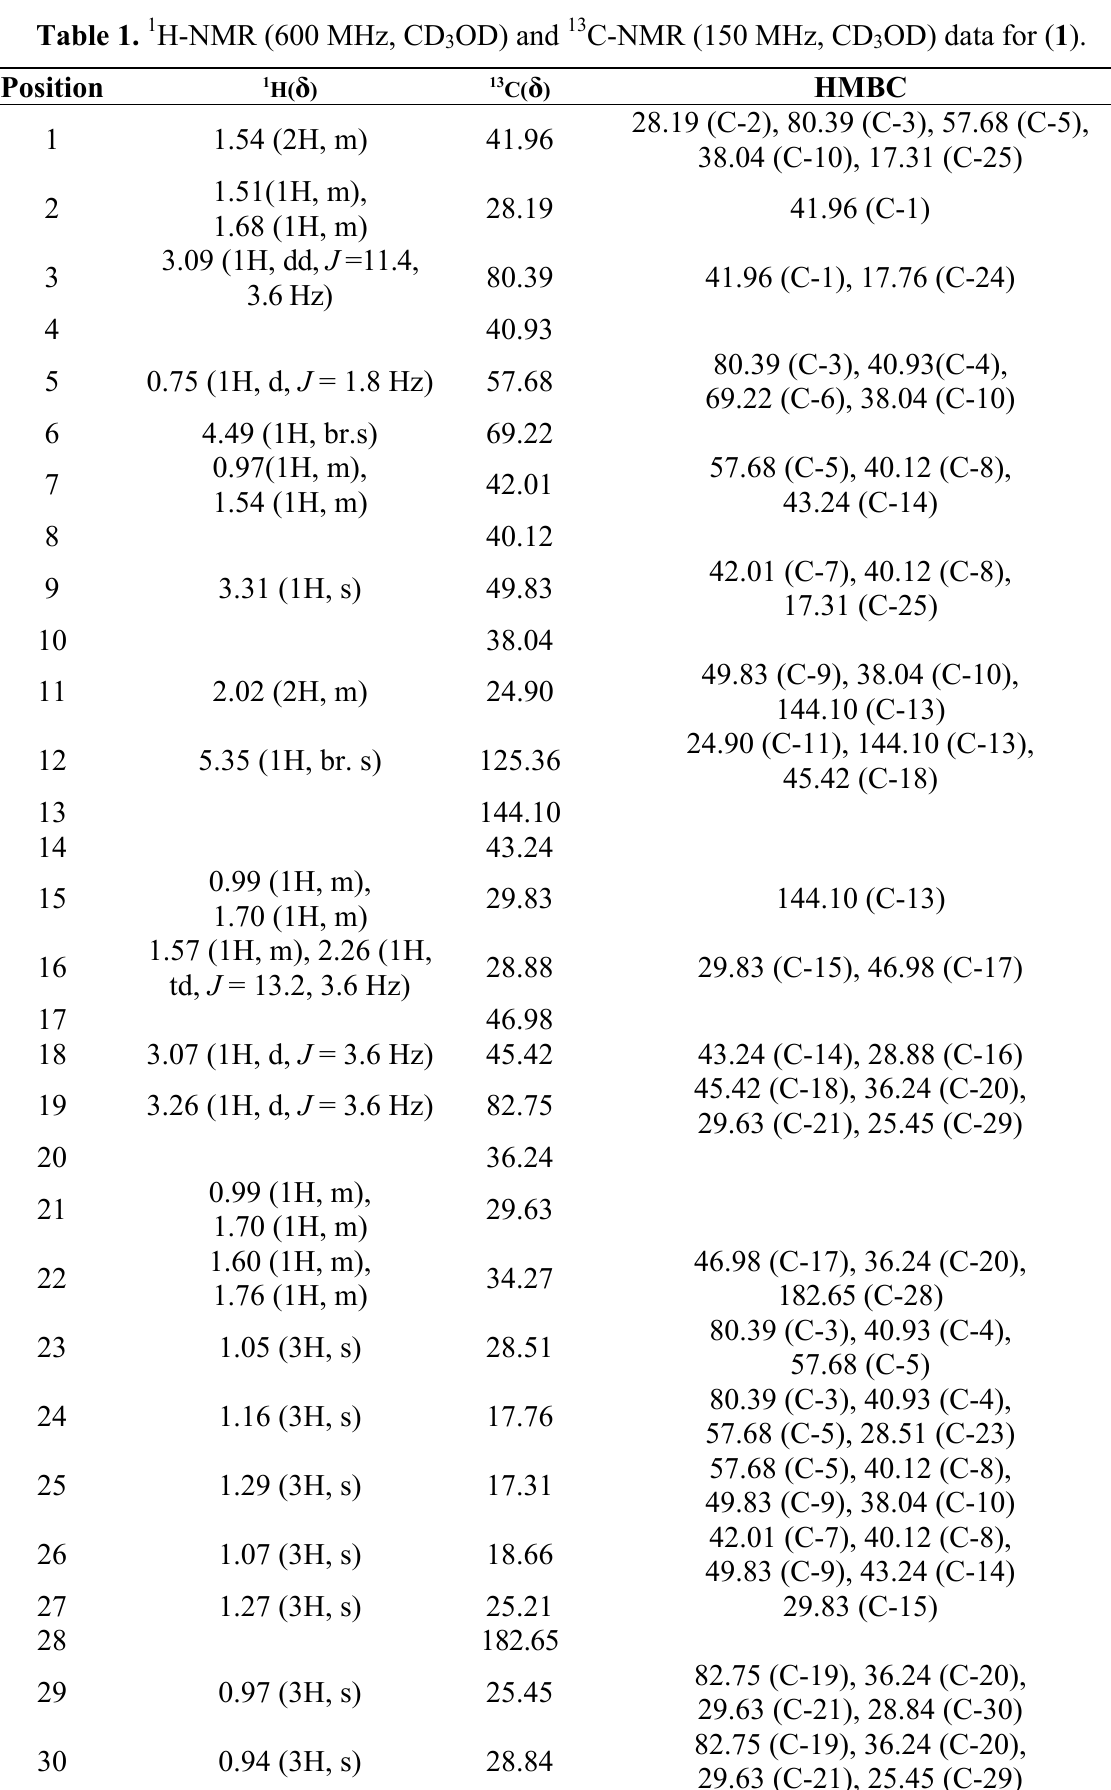
Table 1. 1 H-NMR (600 MHz, CD